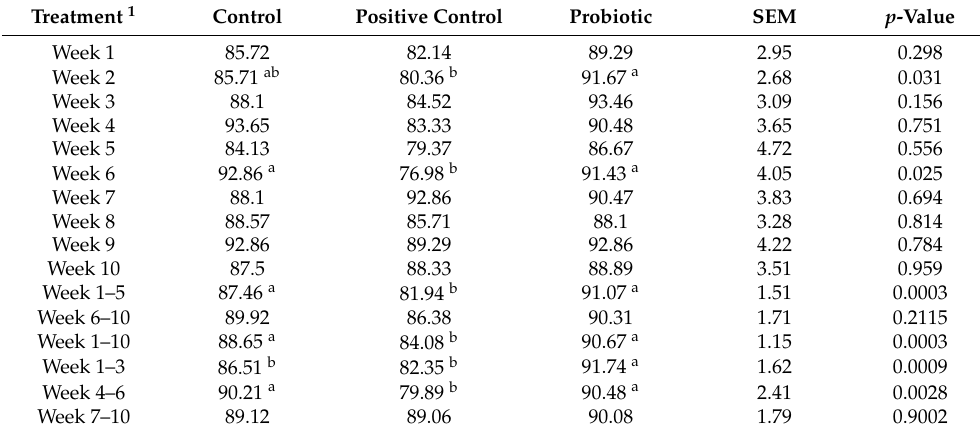
Table 2. Effect of different dietary treatments on hen day egg production (%).